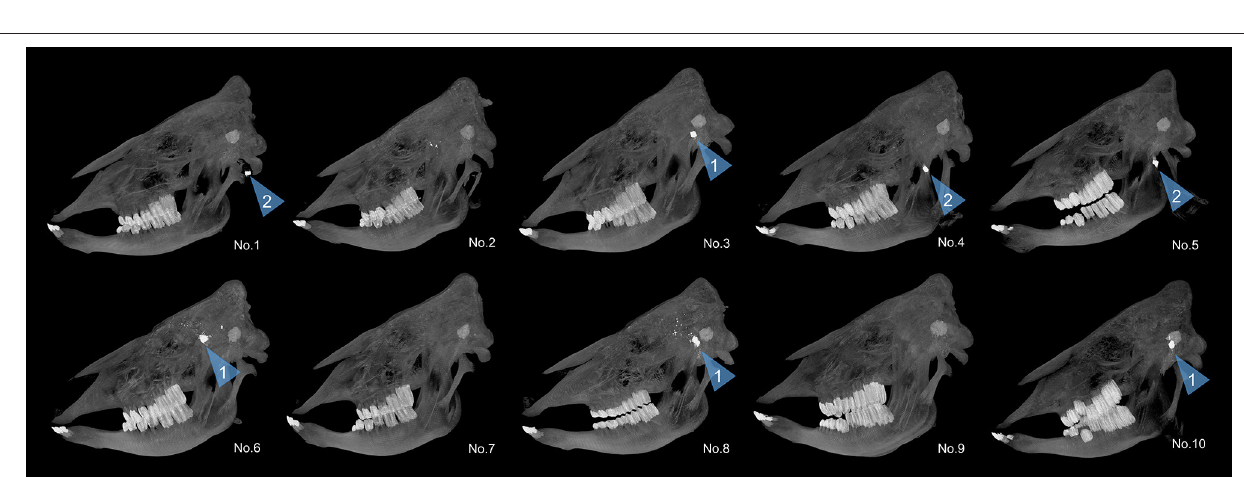
FIGURE 4 | Maximum intensity projection of heavy cattle skulls in sagittal view for demonstration of bullet end positions. In No. 3, 6, 8, and 10, the .38 SPL FMJ-TC was lodged in the posterior cranial fossa of the skull (arrowhead 1). In No. 1, 4, and 5, the bullet perforated the posterior cranial fossa but eventually remained lodged in the soft tissue of the skull (arrowhead 2). In Nos. 2, 7, and 9, the bullet did not show up on CT scans and overpenetration was defined. It should be noted that the distribution of the bone fragments inside the cranial cavity is not visible on these